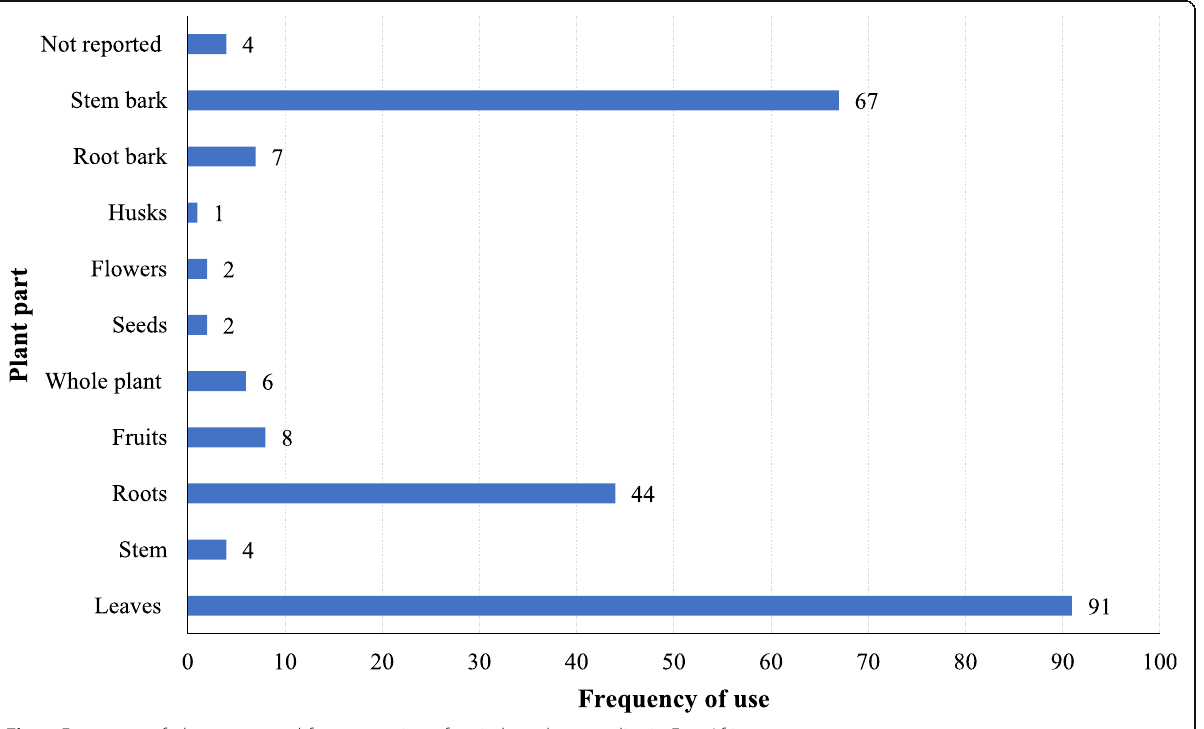
Fig. 4 Frequency of plant parts used for preparation of antitubercular remedies in East